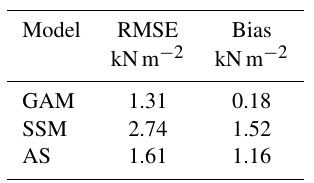
Table 1. Error measures for 50-year return levels of snow load for the generalized additive model (GAM), smooth spa- tial model (SSM) and Austrian standard (AS), calculated using all 897 stations. (687 stations within Austria and below 1500m for AS.) The scores are shifted in favor of the GAM if only sta- tions within the Austrian border and below 1500m are used. The RMSE value of the GAM is only 0.85kNm − 2 then (not